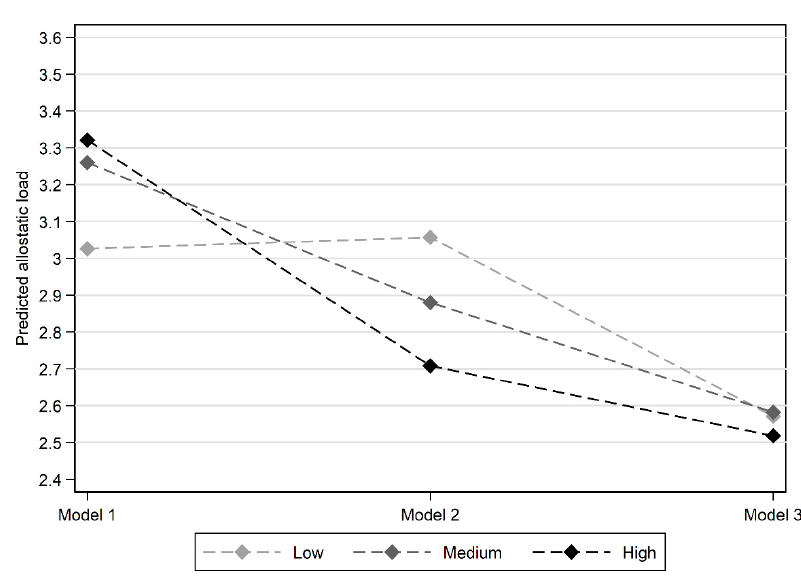
Figure 2. Mean predicted allostatic load score by social capital history for each model.